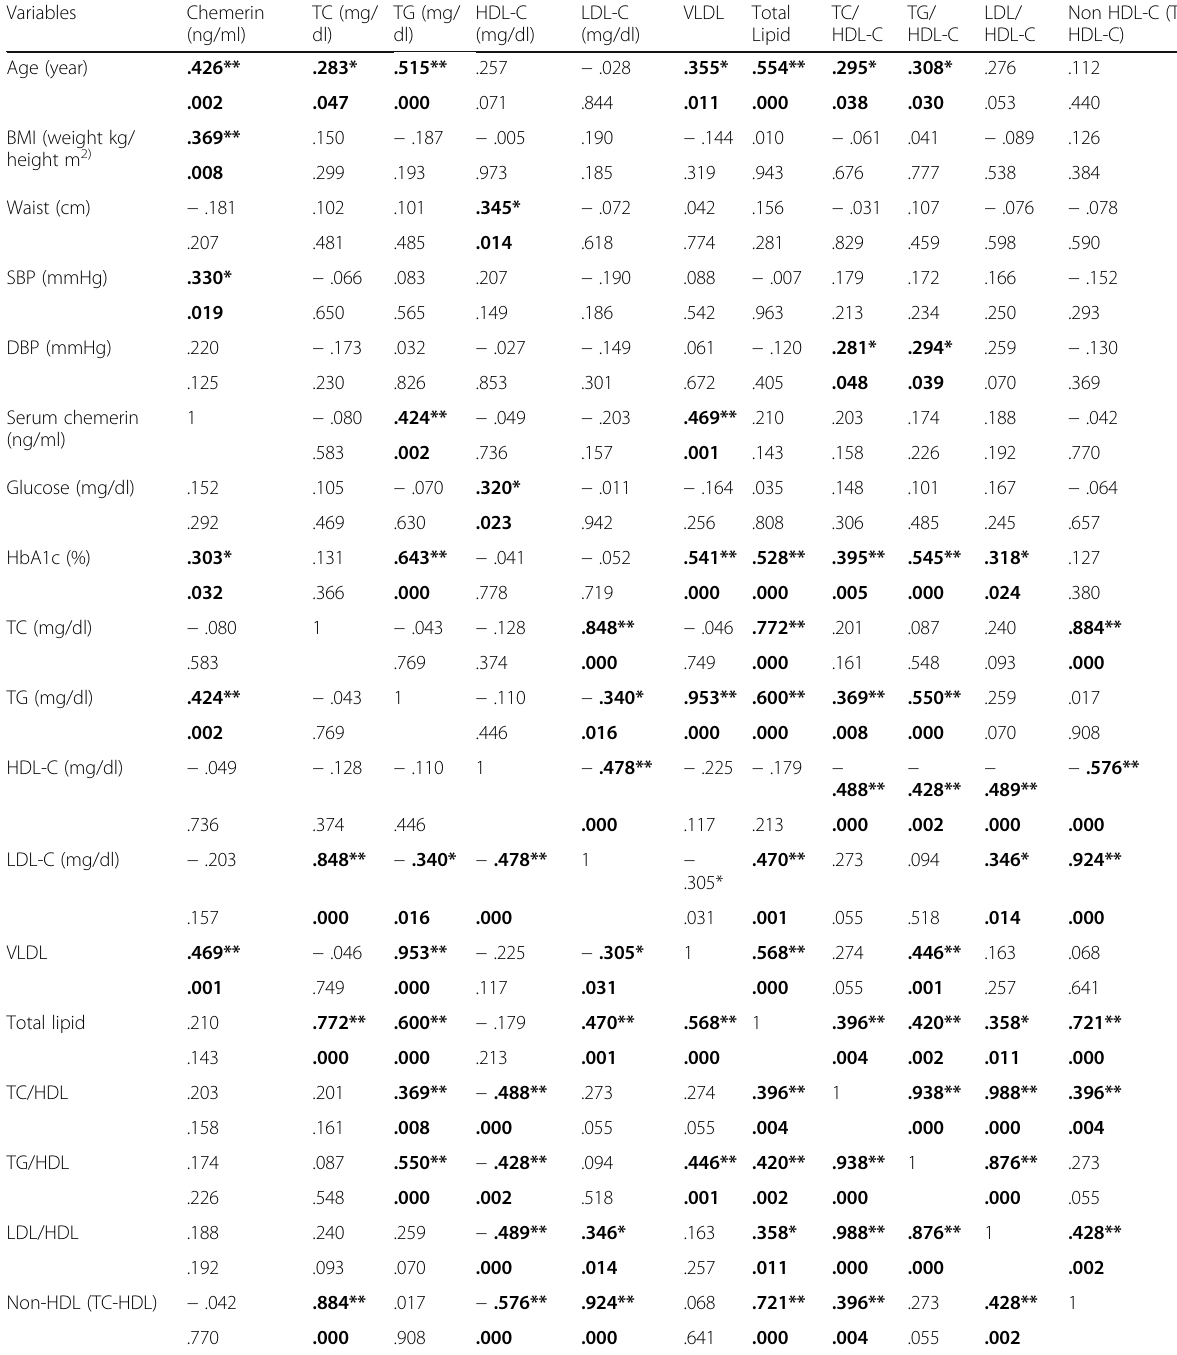
Table 2 Correlation between chemerin serum levels and non-traditional lipid indices with age and other studied parameters in MetS group Variables Age (year) BMI (weight kg/ height m 2) Waist (cm)